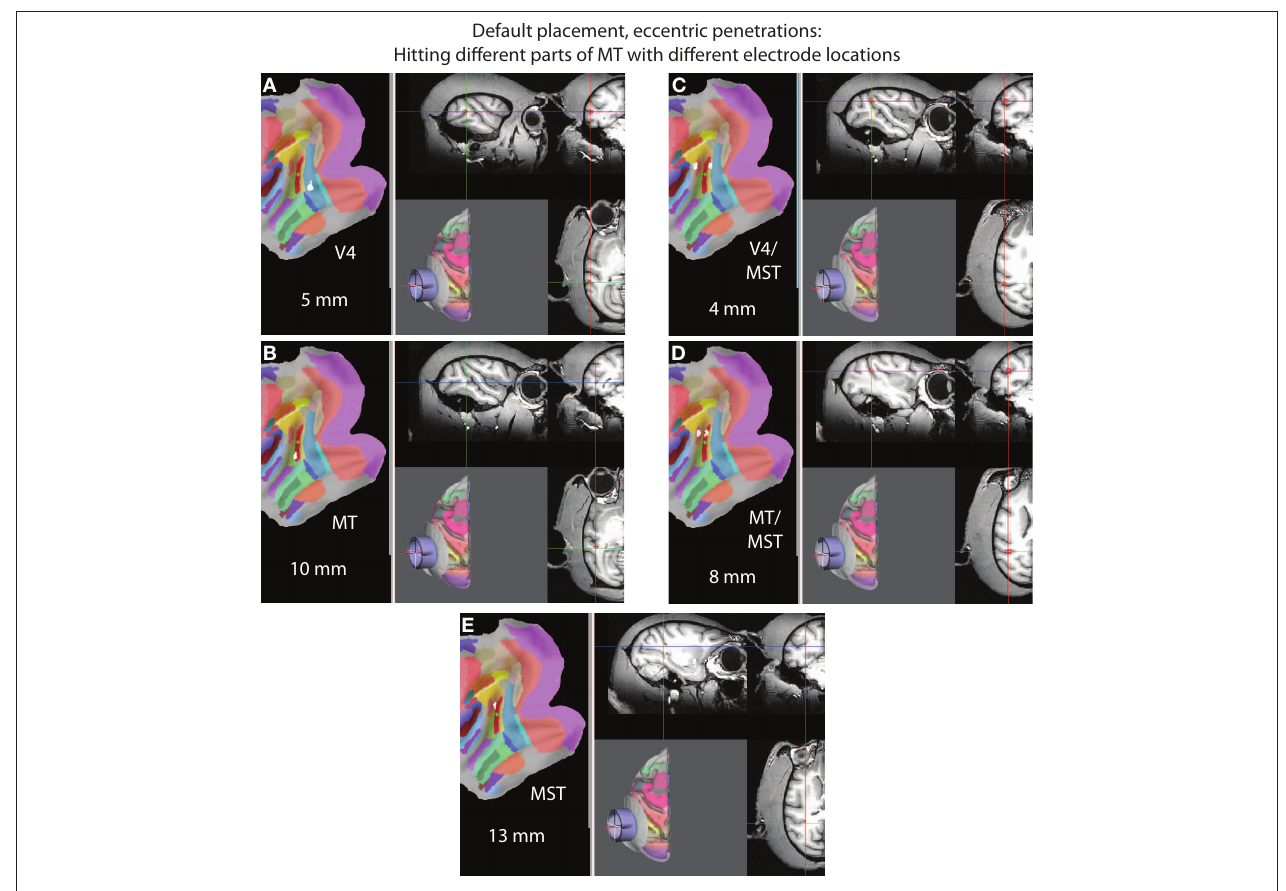
Figure 12 | eccentric virtual electrode tracks when using the default placement. (A) A virtual electrode placed 5 mm to the left of the center of the recording chamber hitting V4 at a depth of 5 mm and (B) MT at a depth of 10 mm. (C) A virtual electrode placed 5 mm to the right of the center of the